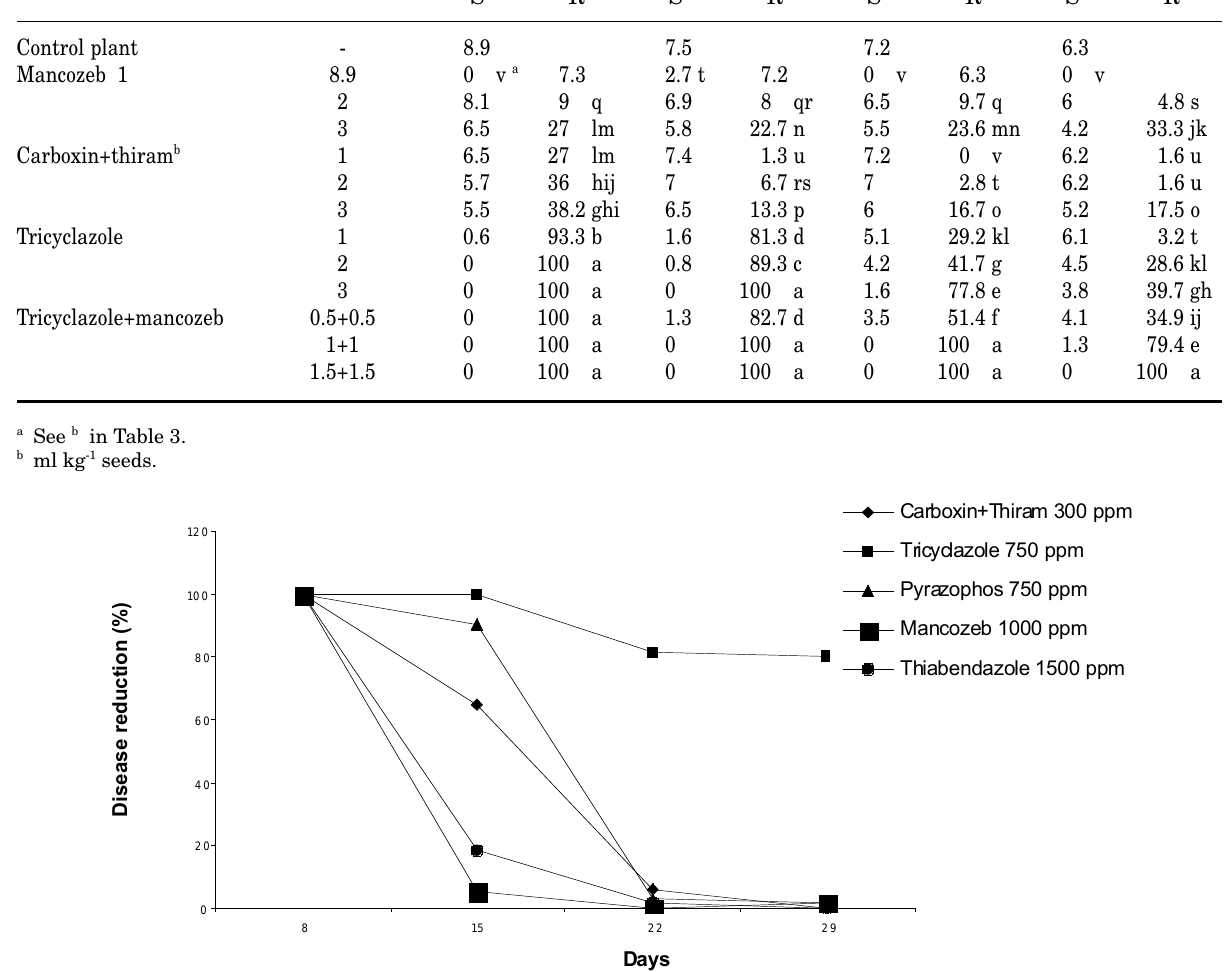
Fig. 1. Percent reduction of blast disease on rice plants inoculated with Pyricularia grisea 8, 15, 22 and 29 days after treatment with fungicides.